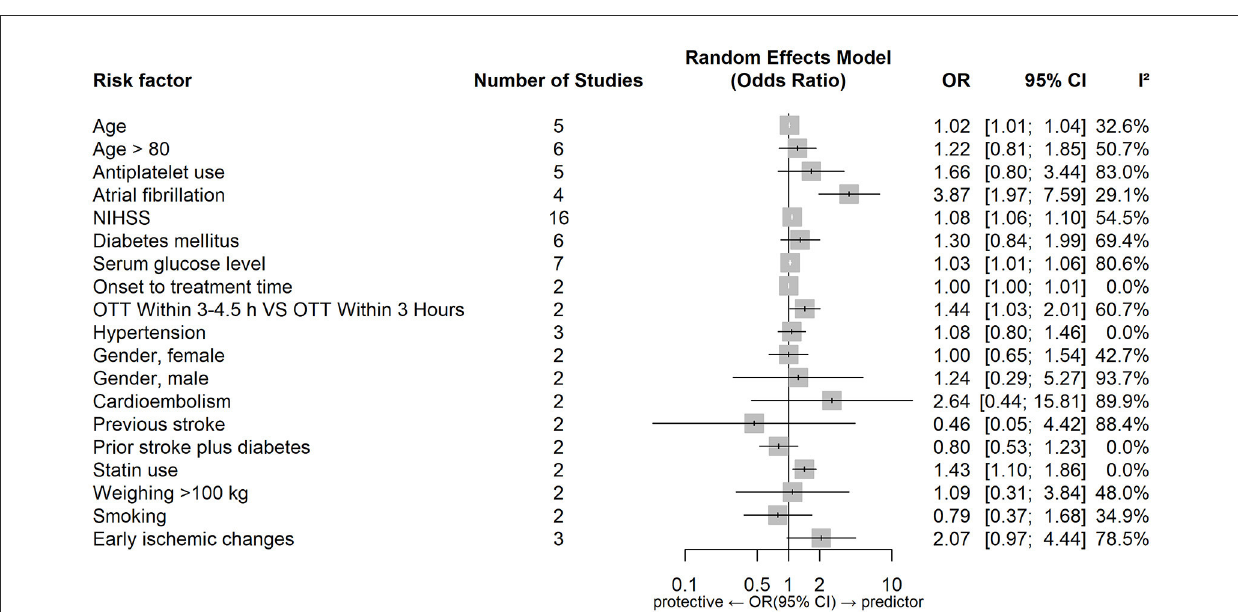
FIGURE4 Forest plot of predictors for sICH after IVT. OR, Odd Ratio; CI, Confidence Interval; NIHSS, National Institute of Health Stroke Scale; OTT, Onset to Treatment